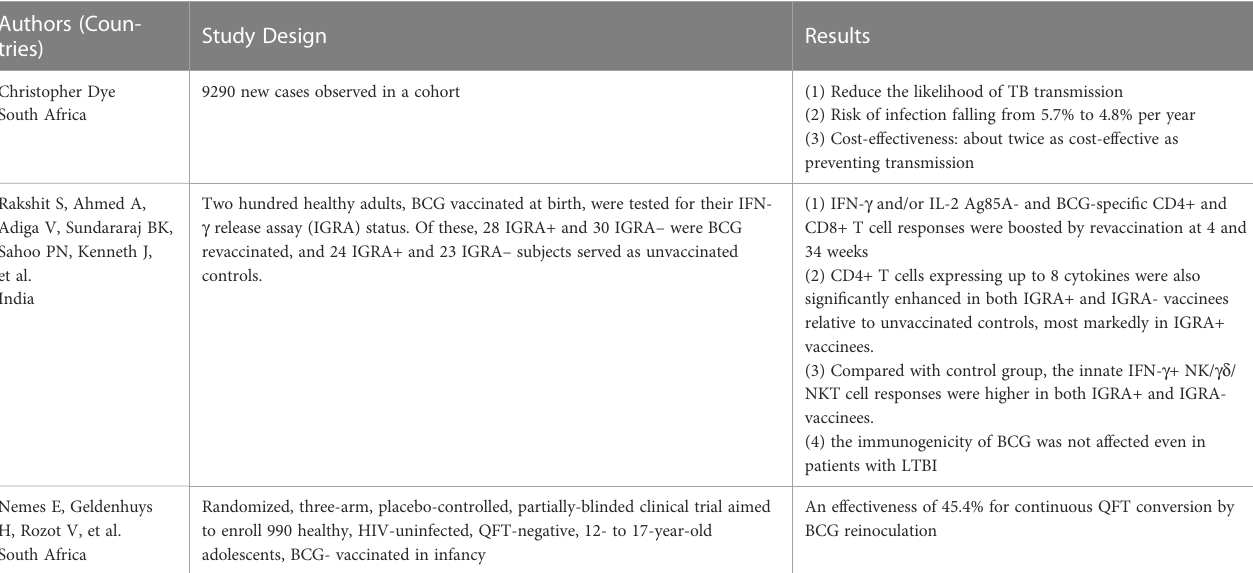
TABLE 1 The research of revaccinating BCG to protect against